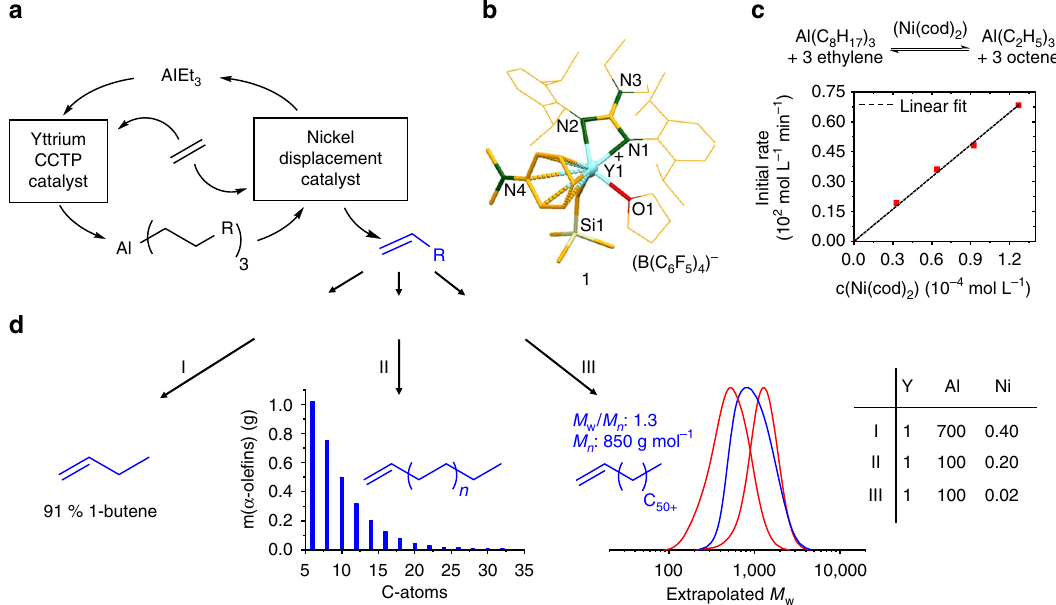
Fig. 1 A broadly tunable synthesis of linear α -ole fi ns applying a trimetallic catalyst system. a Combination of an yttrium coordinative chain transfer polymerization (CCTP) catalyst, triethylaluminum (TEA), and a nickel chain displacement catalyst ( β -H elimination/transfer) permits the highly fl exible formation of α -ole fi ns via variation of the rates of the two catalytic steps. It is not urgent that all three ethyl groups on aluminum are exchanged;